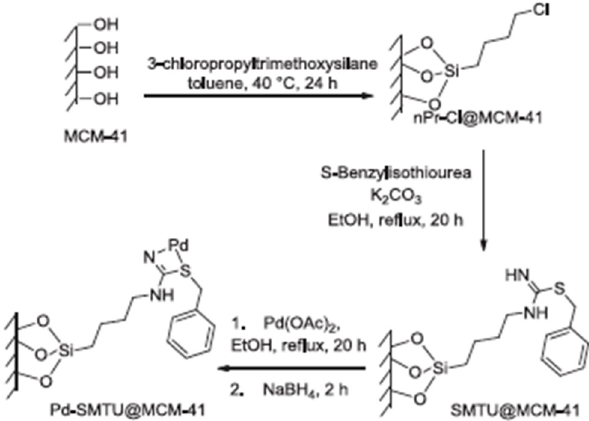
Figure 31. Synthesis of palladium anchored on functionalized MCM-41. steps. Reproduced with